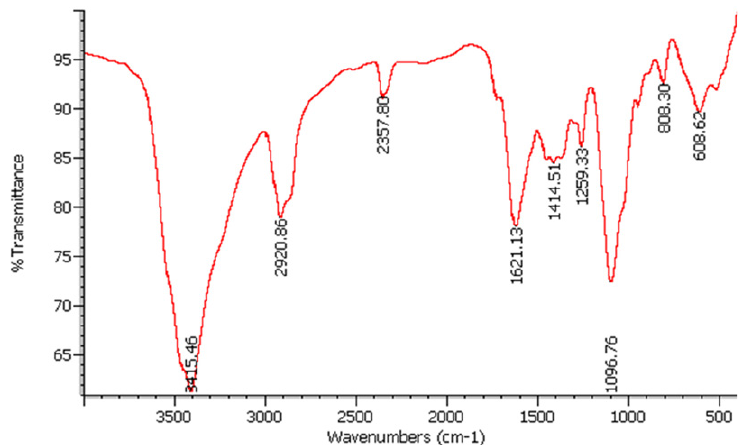
Fig. 2. FT-IR spectrum of CS-CHX composite Fig.2.